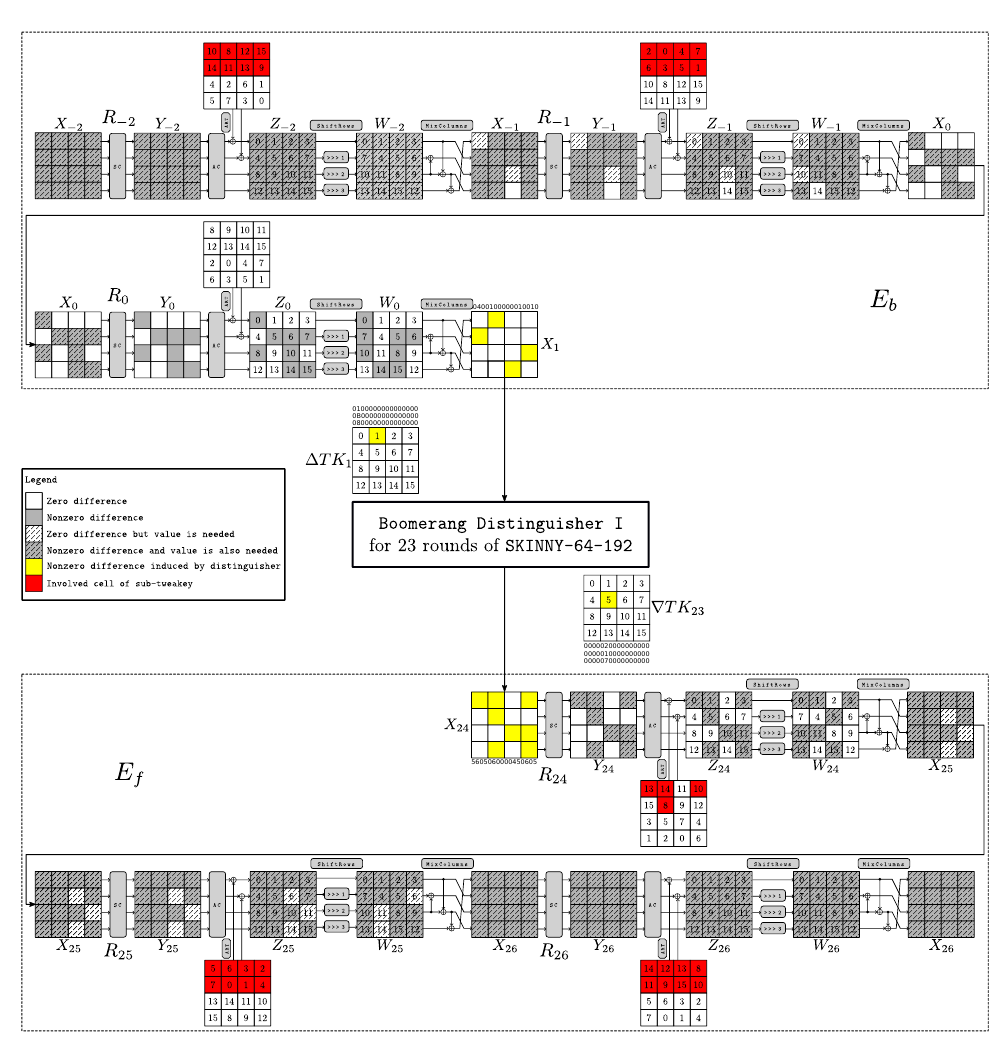
Figure 15: A 29-round key recovery attack against SKINNY